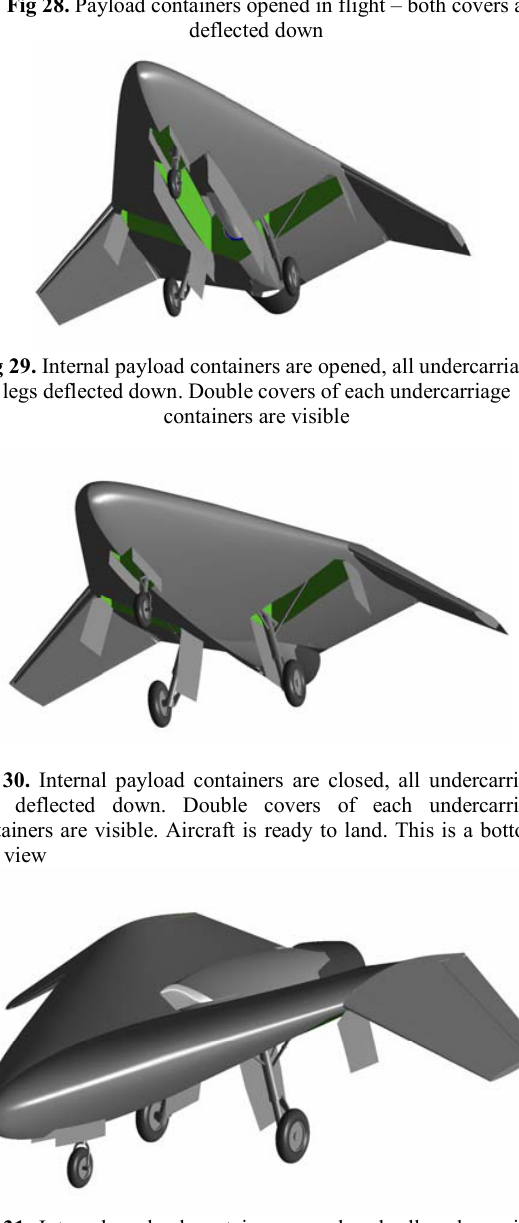
Fig 31. Internal payload containers are closed, all undercarriage legs deflected down. Double covers of each undercarriage containers are well visible. Aircraft is ready to land (This figure supplements Fig. 29 and is a top-side view)